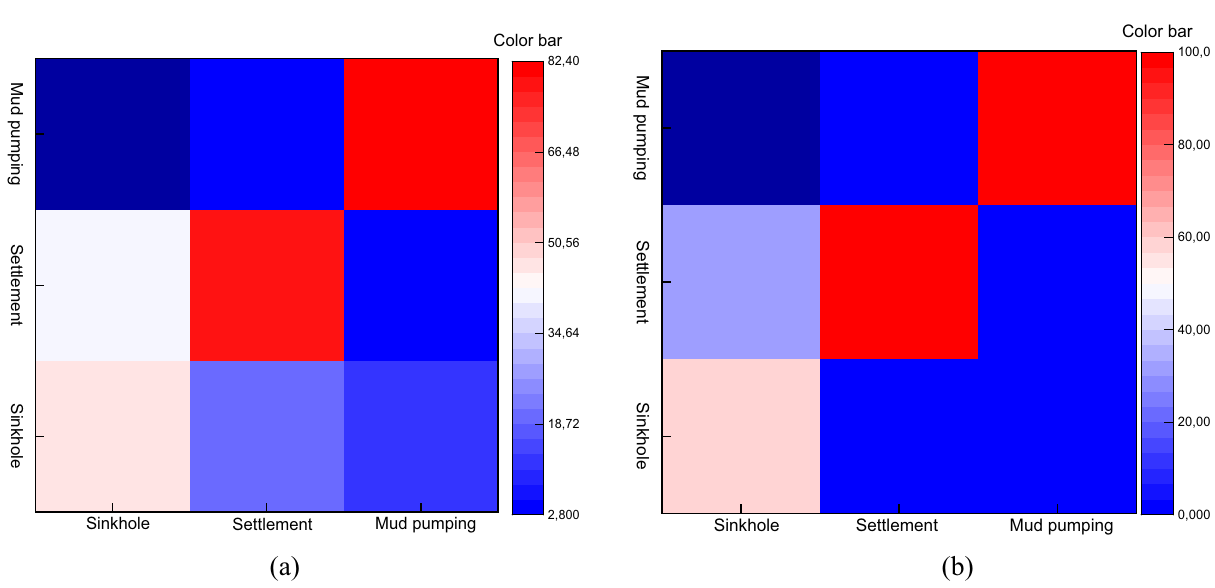
Figure 10. Confusion matrices based on the testing dataset for FCM and FCM-GRNN algorithm, respectively. The X-axis labels are the ground truth labels and the Y-axis labels are the predicted labels. ( a ) FCM algorithm, ( b ) FCM-GRNN